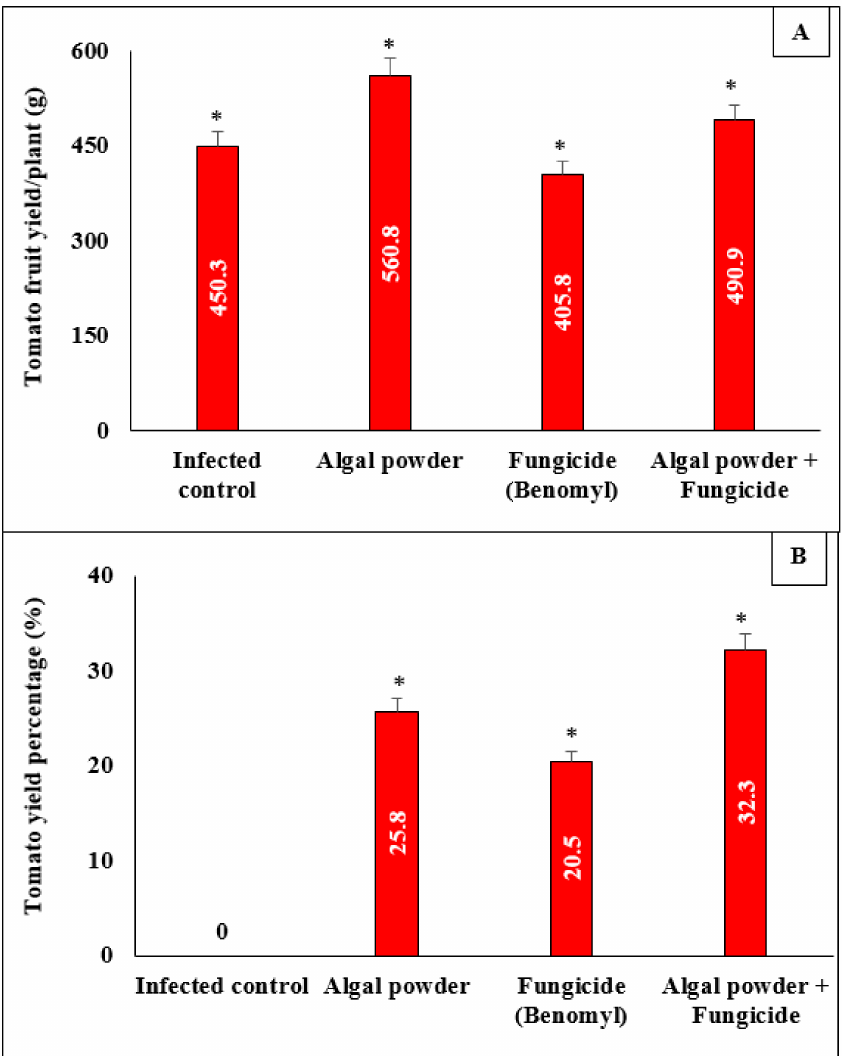
Figure 12. Influence of algal powder of S. dentifolium (10%) on tomato fruit yield. ( A ): tomato fruit yield/plant (g). ( B ): tomato yield percentage (highly significant = * p < 0.05, n =